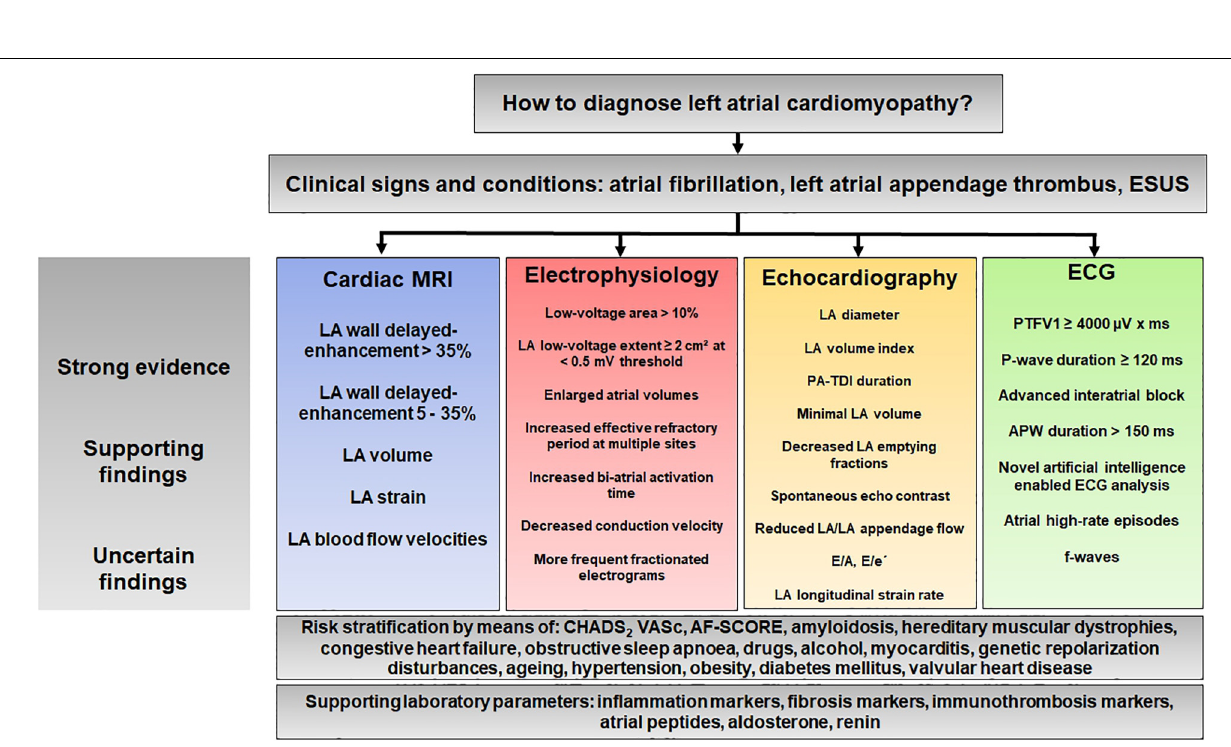
Frontiers in Cardiovascular Medicine |